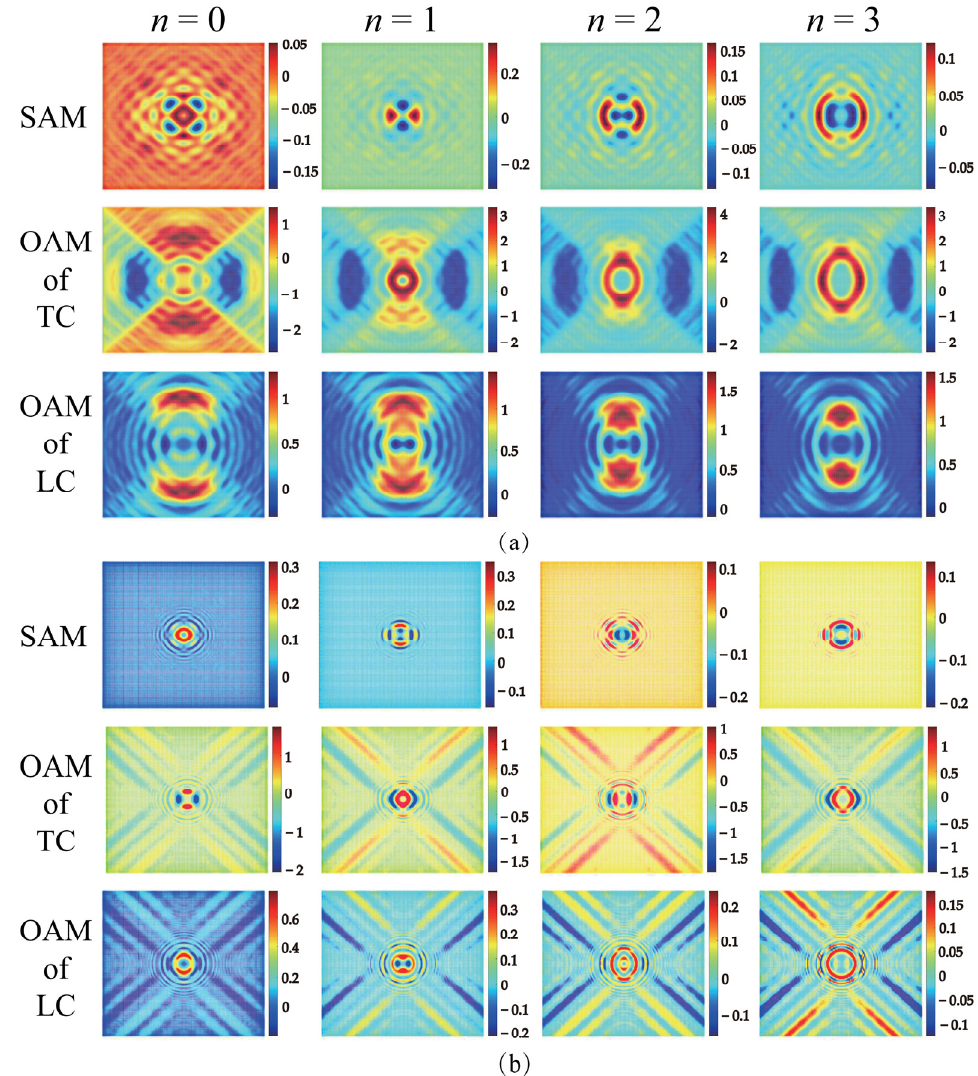
Figure 5. The SAM and OAM distributions of a focused scalar linear polarized beam (the initial field with m = 0 and φ 0 = 0 in Equation (1)) in the focal region with different vortex topological charge numbers and the modulation of a twisting phase: ( a ) the twisted strength u = 10 13 mm − 2 , ( b ) the twisted strength u = 8 × 10 13 mm − 2 . Here the size of each plot is 3 λ × 3 λ .